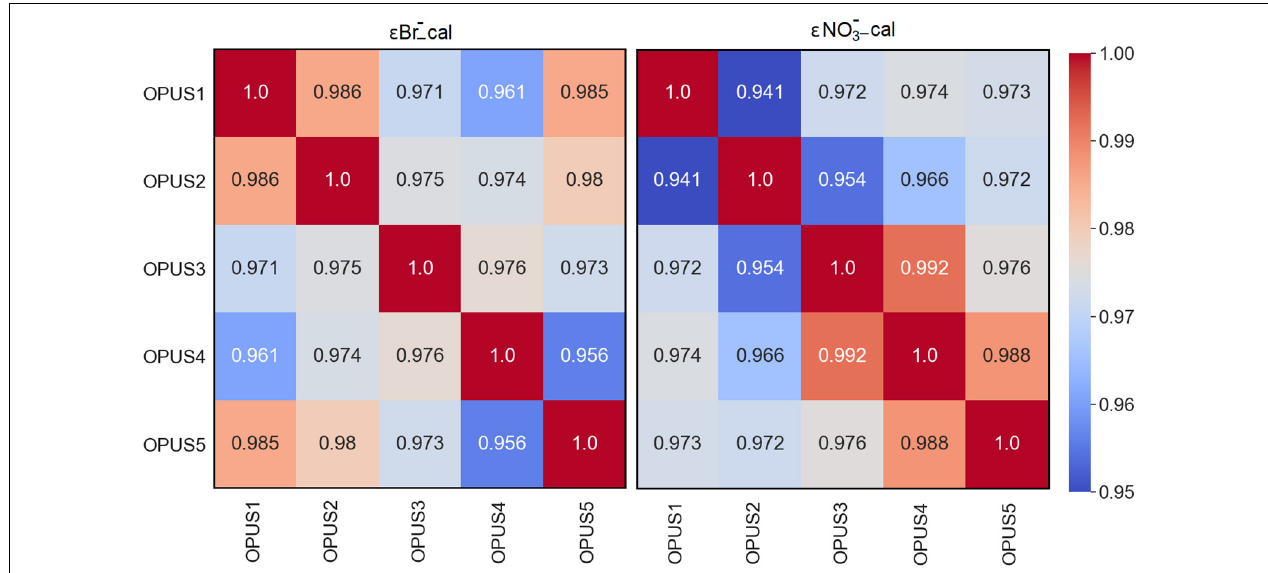
for the OPUS sensors used. 3 _ cal